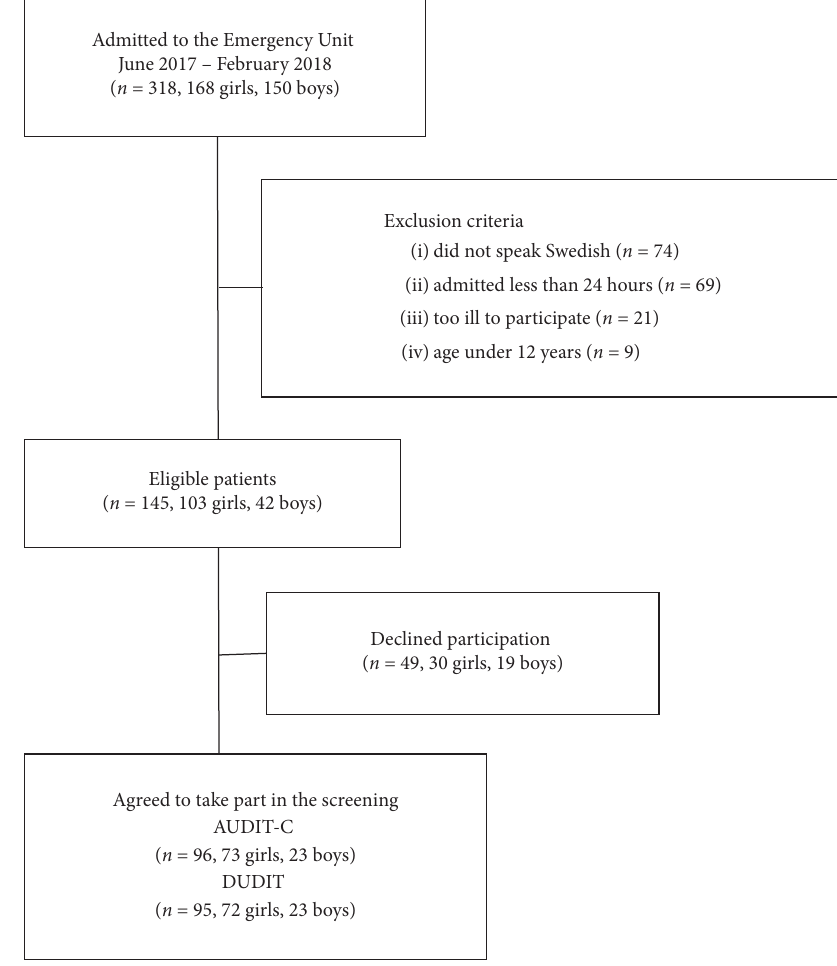
Figure 1: Patient flow